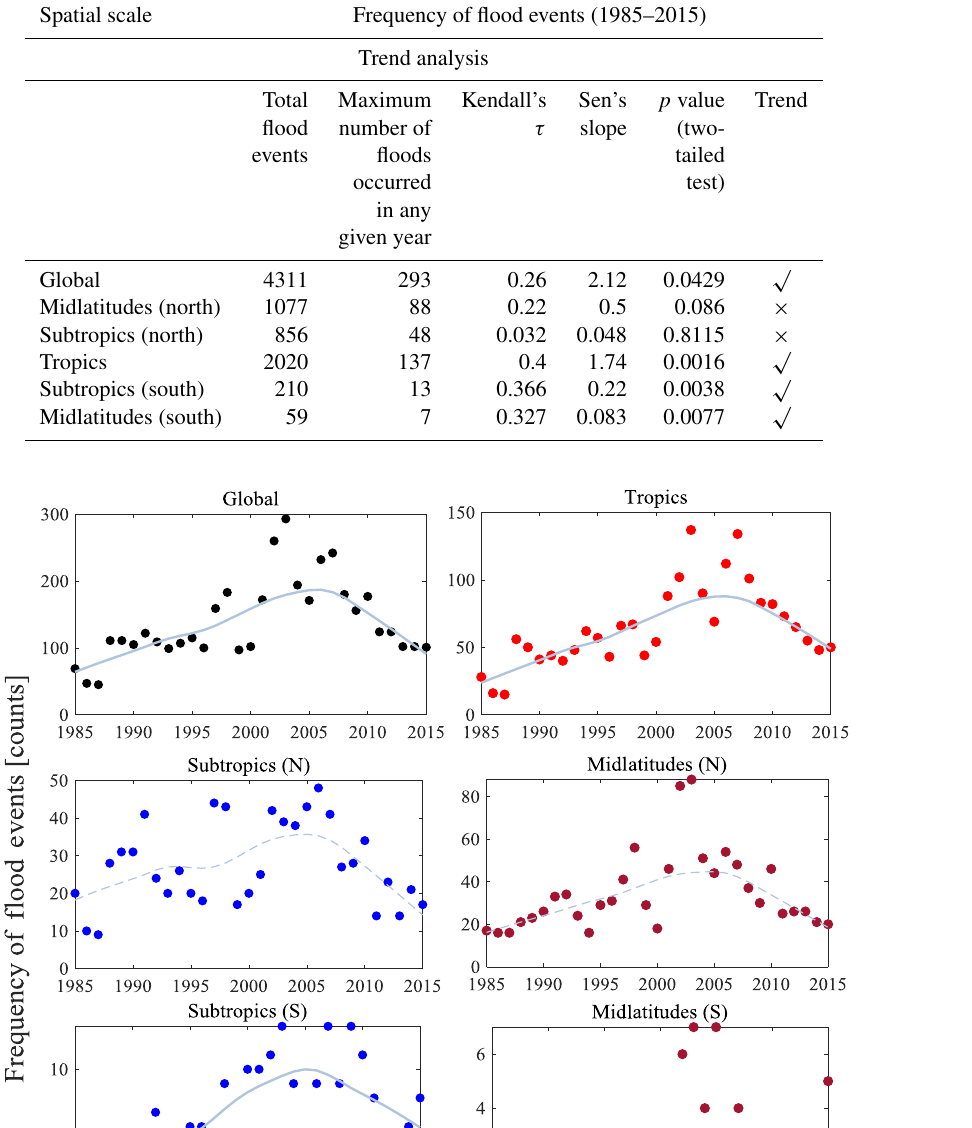
Table 2. Summary of trend analysis (Mann–Kendall test with a significance level α = 0.05) on the frequency of flood events at the global scale and the five latitudinal belts.